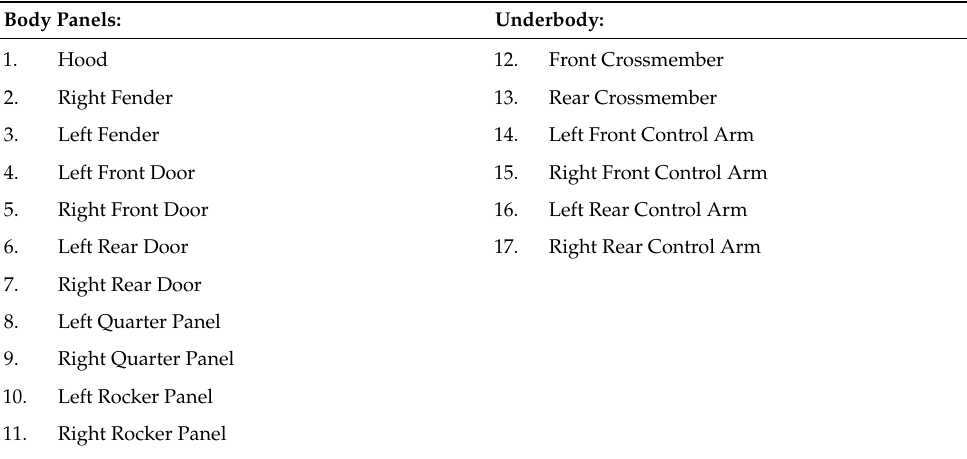
Table 1. Targeted corrosion-prone part types used for corrosion assessment. Body